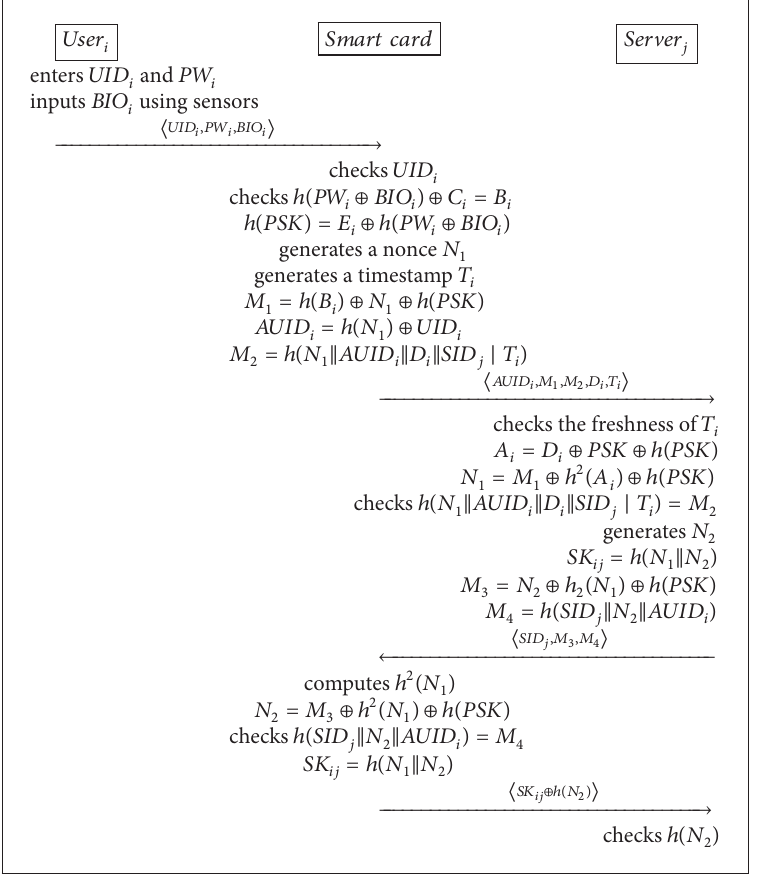
Algorithm 5: Our login and authentication